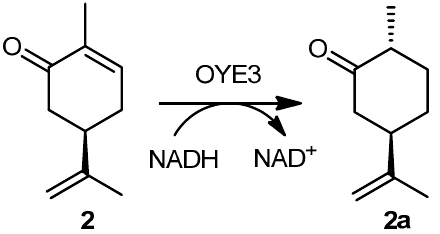
Figure 2. Stability of soluble OYE3 (green circles), OYE3-GA (blue squares) and OYE3-EziG